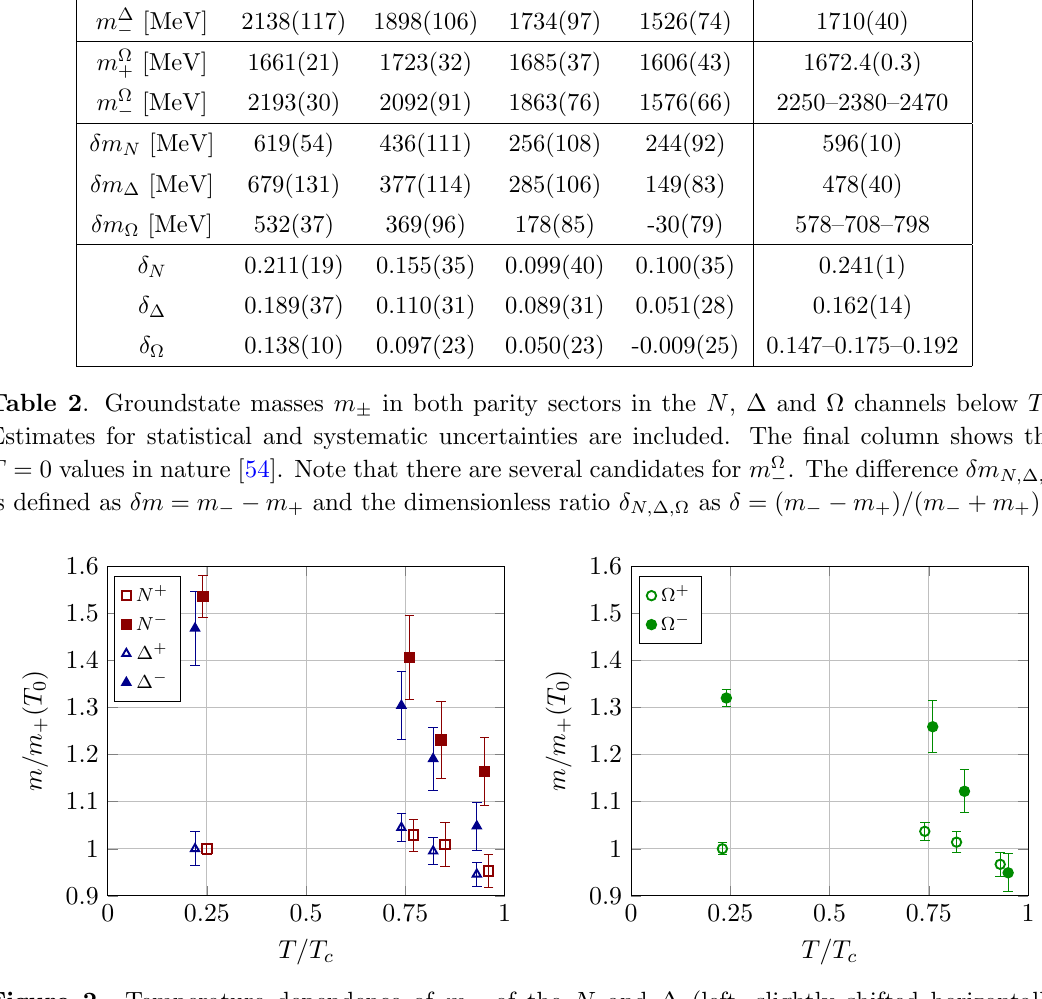
Figure 2 . Temperature dependence of m (cid:6) of the N and (cid:1) (left, slightly shifted horizontally for clarity) and (cid:10) (right) baryon, below T c . The masses are normalised by m + at the lowest temperature, T 0 = 0 : 24 T c , in the channel under